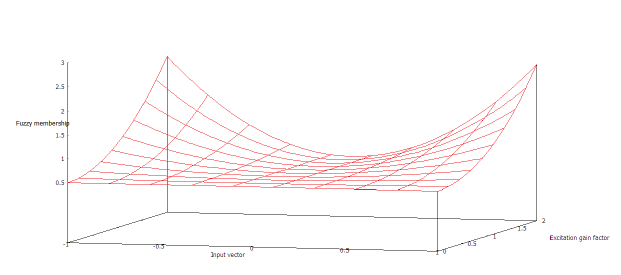
Fig. 5. Dynamics of fuzzy function for (cid:16) 1 (cid:100) I 1 and 0 < k < 2. (cid:68) n (cid:100) The characteristic variation of fuzzy function (y-axis) for unit gain (i.e. linear mapping of excitation) for the Fig. 8. Characteristic map of constrained (cid:86) ( x , y corresponding varying input vector (x-axis) is illustrated in Fig. 6. According to natural observations, the evolution of state of consciousness is gradual. In order to understand